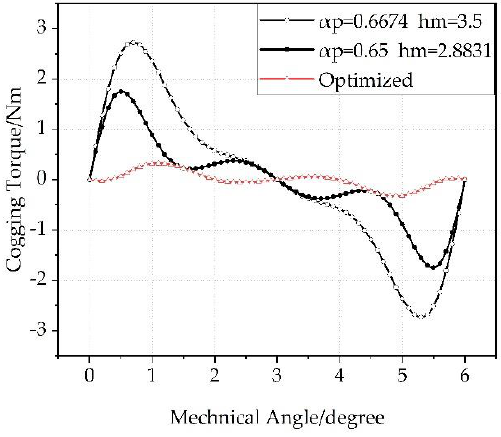
ff erent auxiliary pole